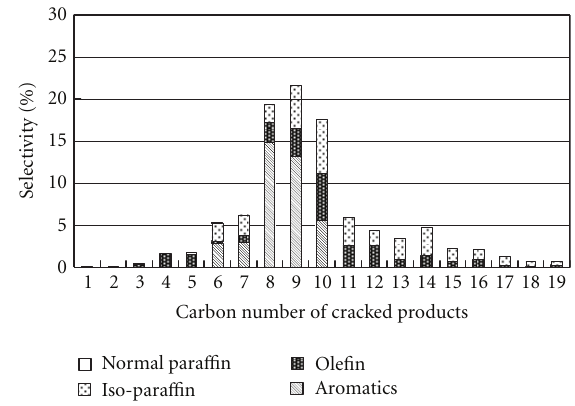
Figure 5: Product distribution from hydrocracking of nonhy- drotreated oil over [NiMo/ γ -Al 2 O 3 ]/ ns Al 2 O 3 /H-beta zeolite cata- lyst at 350 ◦